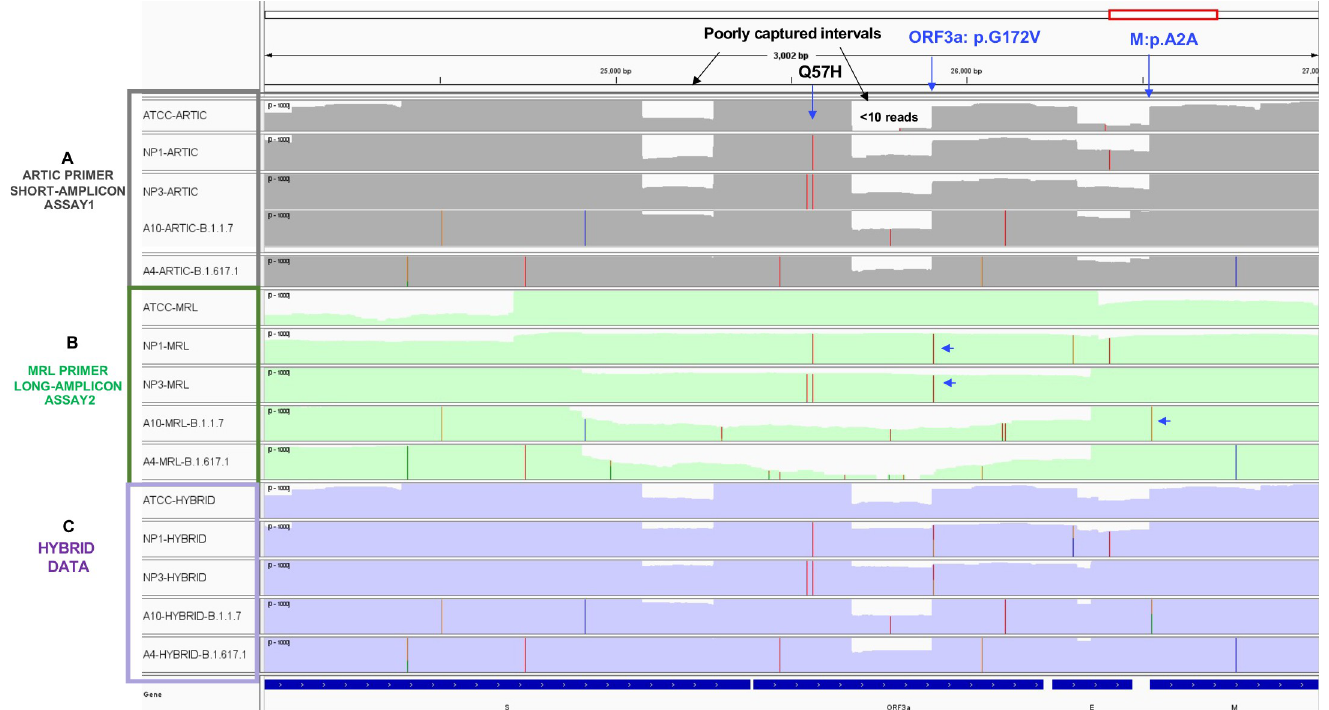
Fig 3. Short plus long-amplicon hybrid data provide uniform and maximum genomic coverage. The Integrative genomics viewer (IGV) plot shows sequencing coverage tracks in ATCC positive control and four patient samples based on ARTIC primers (short-amplicon data in panel A), MRL primers (long-amplicon in panel B) and Hybrid data (short + long-amplicons in panel C). Data is shown for ATCC RNA and four patient samples (NP1, NP3, A10 and A4) in each panel. The x-axis shows the genomic position in virus genome and the y-axis shows the individual samples. Top panel grey tracks represent ARTIC data, middle panel green tracks represent MRL data and bottom panel purple tracks represent Hybrid data. Colored lines on the sequencing coverage tracks indicate detected mutations. Black solid arrows point to the poorly captured genomic intervals in ARTIC data set. Blue solid arrows point to examples of three mutations, Q57H, G172V and A2A mutations.